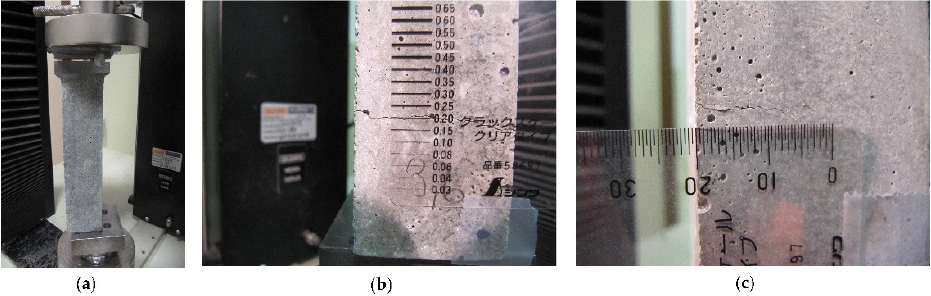
Figure 1. Cracking procedure: ( a ) test rig for eccentric axial compression; ( b ) width and ( c ) depth of induced